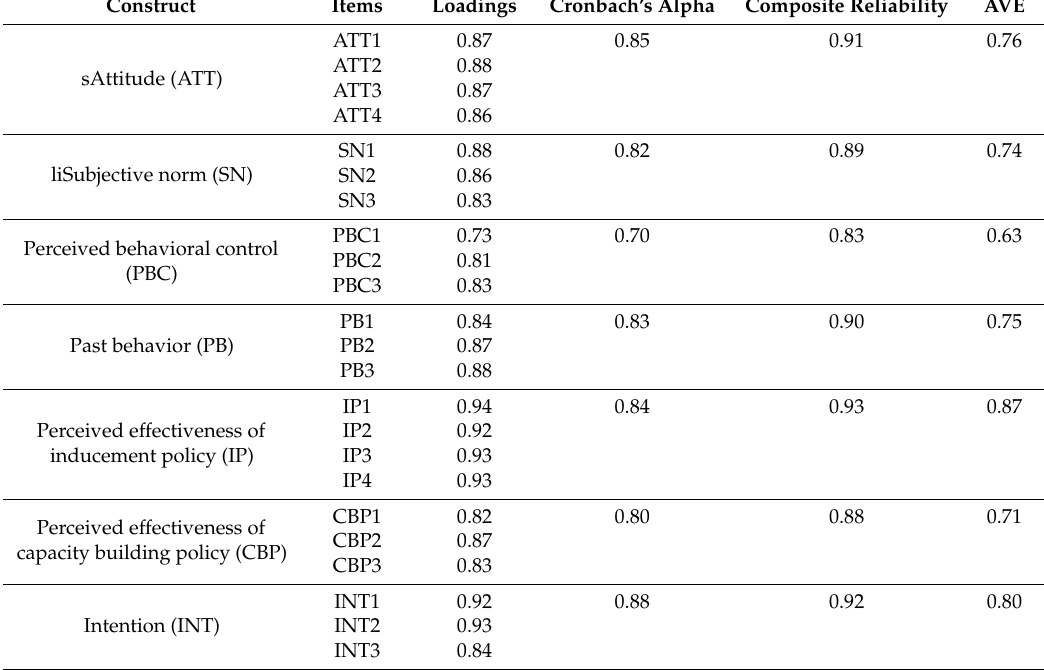
Table 3. Results of confirmatory factor analysis.